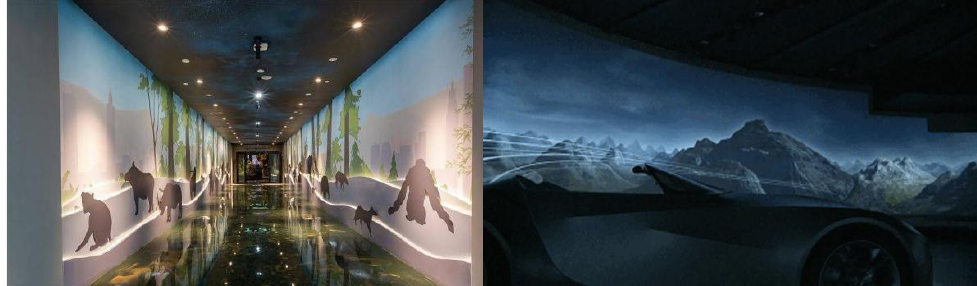
Figure 7. Visual effect of a virtual museum.